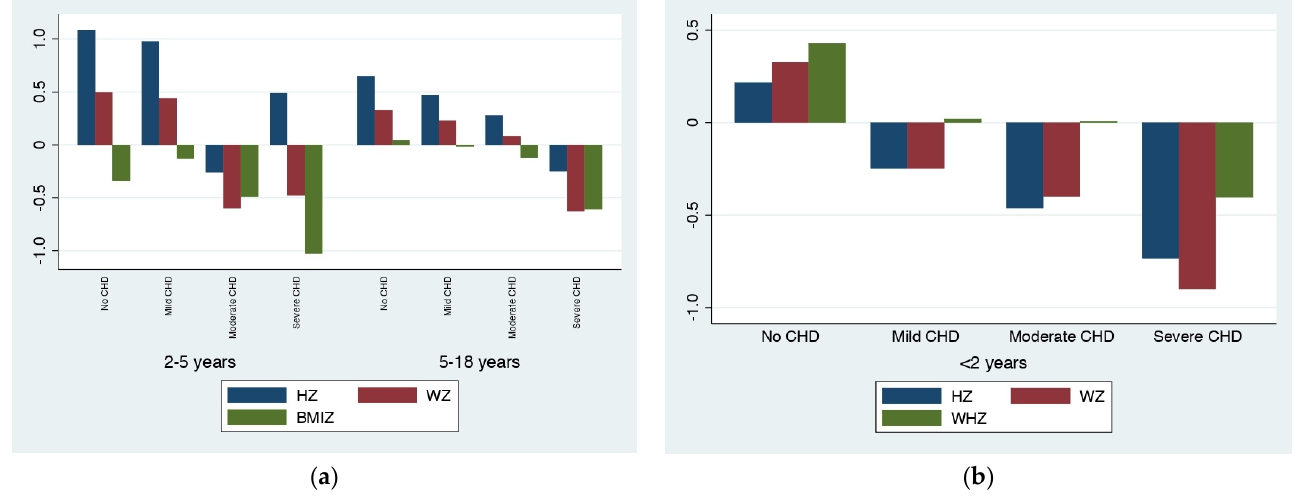
Figure 2. ( a ) Graphical distribution of mean length/height-for-age z-score (HZ), weight-for-age z-score (WZ) and Body-Mass-Index-for-age z-score (BMIZ)according to Congenital Heart Disease (CHD) severity in children older than 2 years old, divided into age groups; ( b ) Graphical distribution of mean weight-for-height z-score (WHZ) according to CHD severity in children younger than 2 years of age.